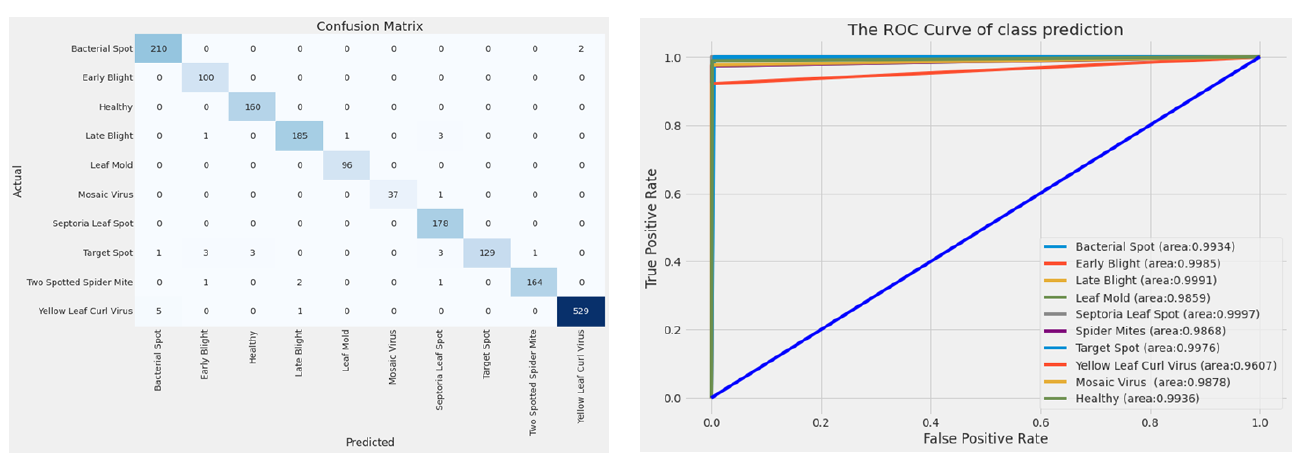
Figure 7. Confusion matrix and ROC curve of InceptionResNet model on the tomato test data.